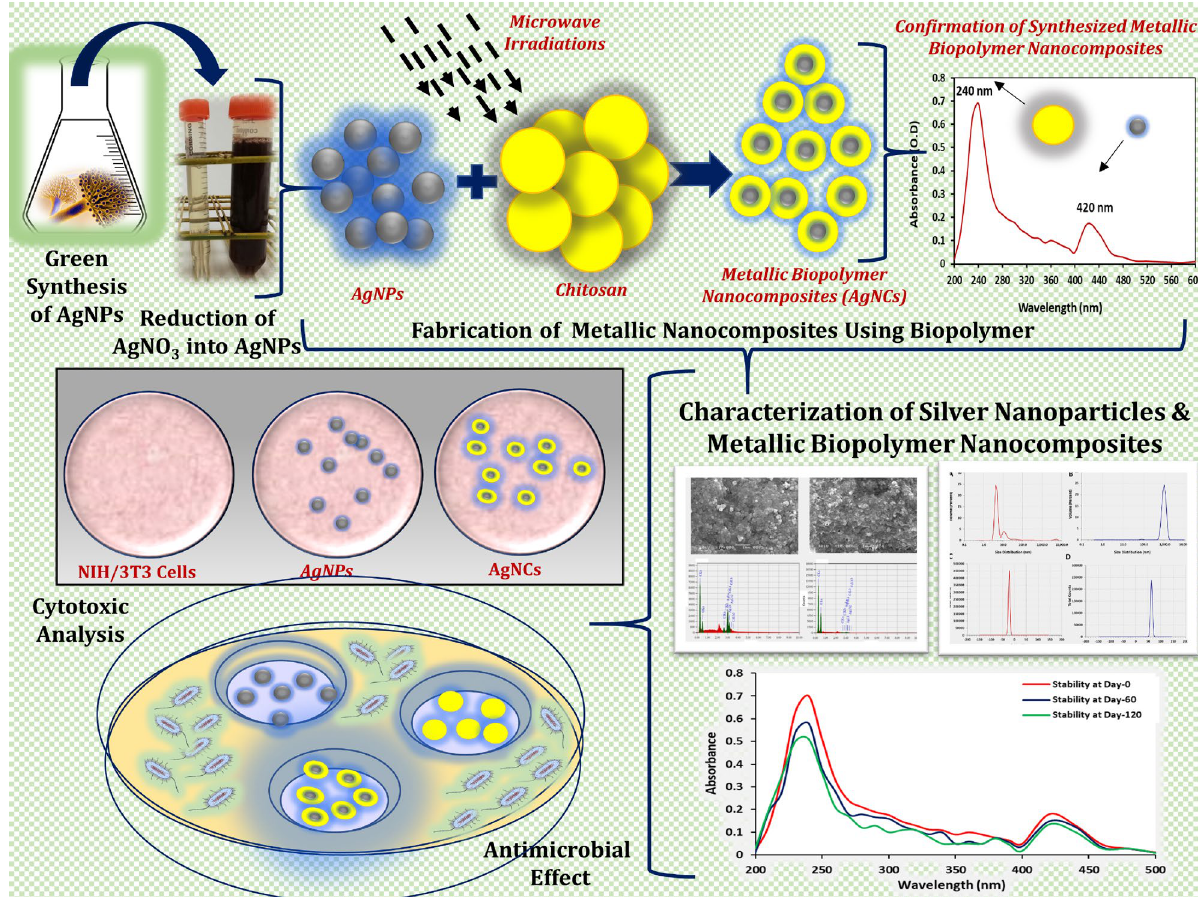
Figure 1. Schematic illustration of the biogenic synthesis and characterization of silver nanoparticles (AgNPs) and the fabricated nanocomposite system